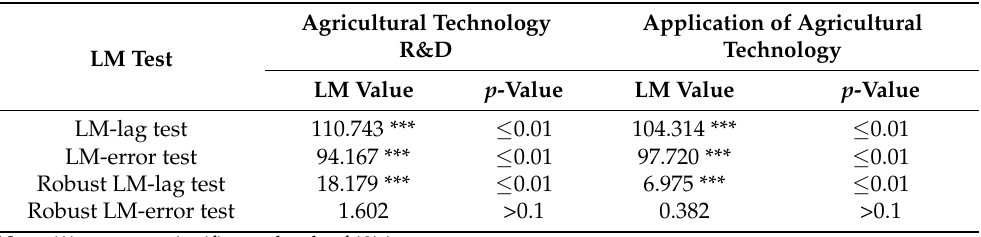
Table 8. LM test of regression results between agricultural science and technology innovation and green agricultural development under economic